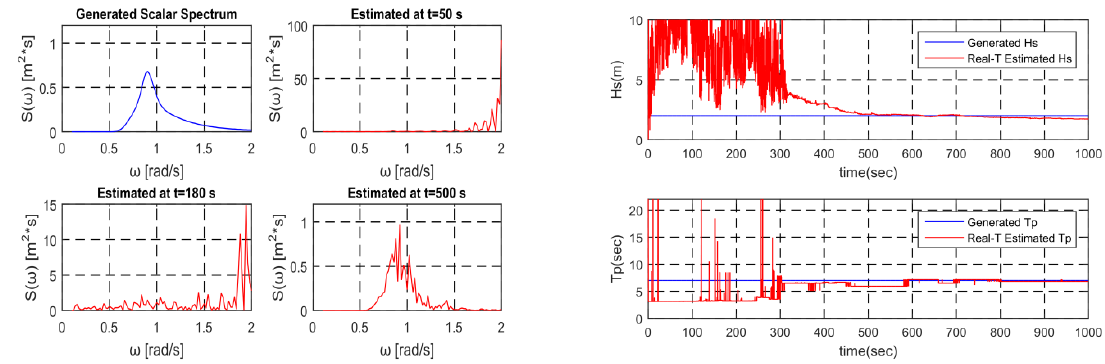
Figure 16. Generated and estimated spectrum / Evolution of parameters using Modified TF (Hs = 2 m, Tp = 7 s, Frequence: 0.1~2.0 rad/s).